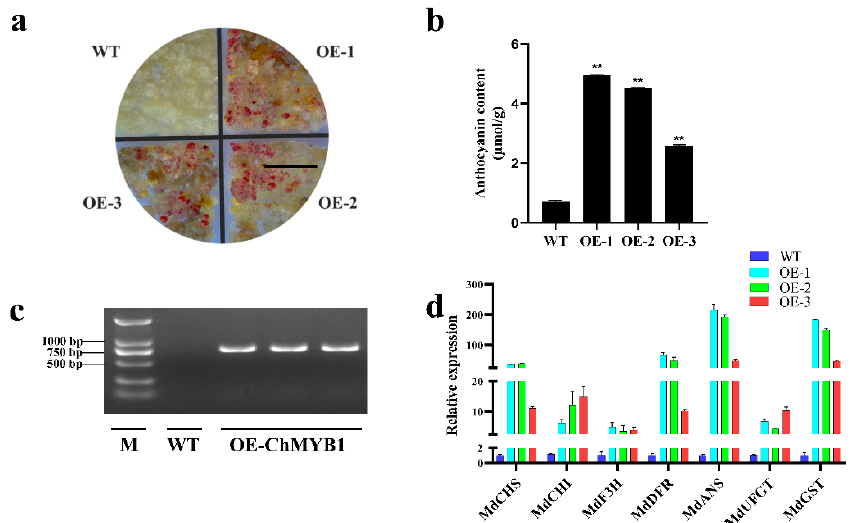
Figure 7. Overexpression of ChMYB1 increases anthocyanin accumulation in apple calli. ( a ) Pigmen- tation phenotypes of flowers of untransformed calli (WT) and three ChMYB1 -overexpressing apple calli lines (OE1, OE2, and OE3). ( b ) Anthocyanin content in ChMYB1 -overexpressing apple calli. At least three independent experiments were performed for each sample, and a representative result is shown. Data are shown as the mean ± SD. ( c ) Confirmation of the presence of the transgene in OE-ChMYB1 calli by PCR analysis. M, 2000bp. ( d ) Expression profiles of anthocyanin biosynthesis- related genes ( MdCHS , MdCHI , MdF3H , MdDFR , MdANS , MdUFGT, and MdGST ) of WT, OE1, OE2, and OE3 in apple calli. ** above, the columns are significantly different at p < 0.05. Scale bar, 1 cm.